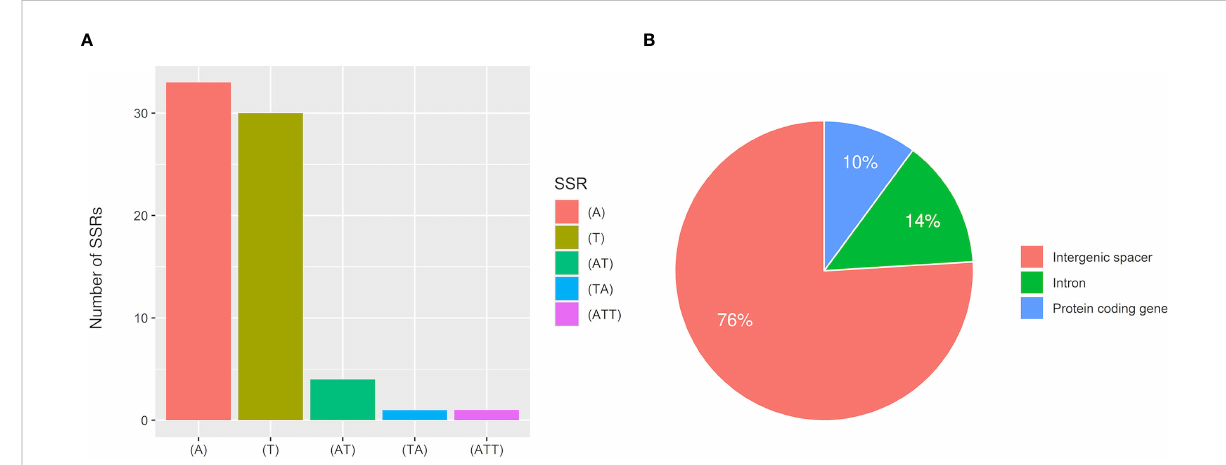
FIGURE 9 Statistical analysis of SSRs in T. esculentum chloroplast genome by MISA. (A) Number of identi fi ed SSR motifs in different repeat types (B) Location distribution of SSR repeats.